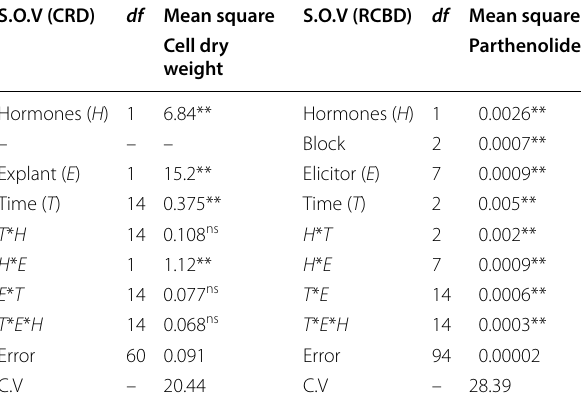
S.O.V, source of variations; df , degree of freedom; CRD, completely randomized design; RCBD, randomized complete block design; ns, not significant **Significantly different ( P 0.01) ≤